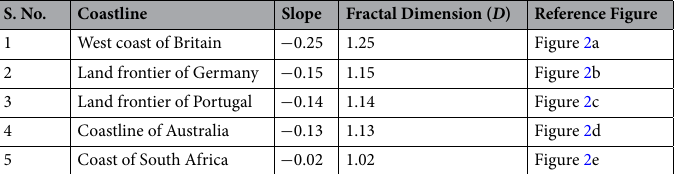
Table 1. Slopes for coastlines computed by Richardson 35 and fractal dimension ( D ) computed by Mandelbrot 28